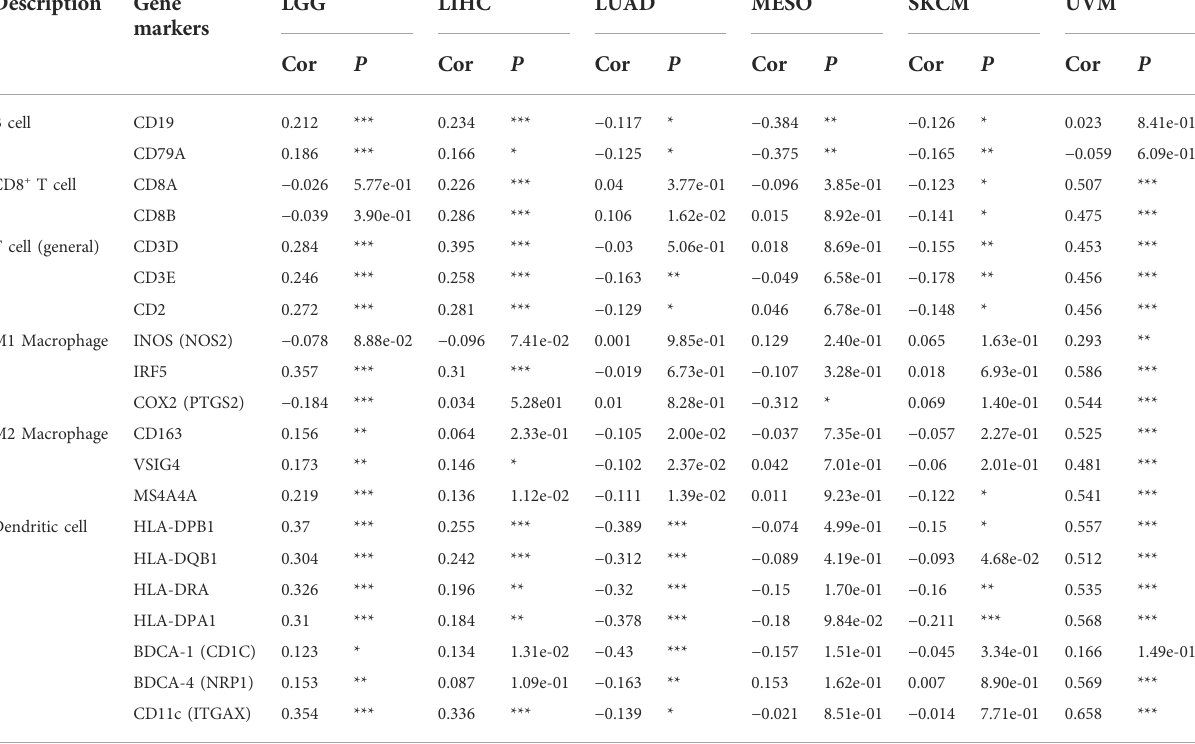
TABLE 1 Correlation analysis between DTYMK and immune in fi ltration markers in TIMER. Description Gene